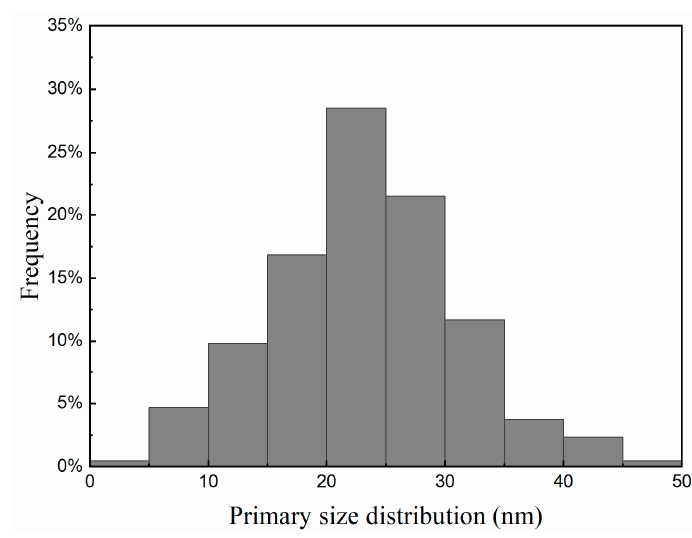
Figure 2. The primary size distribution of GDI PM. The accumulation of numerous primary particles created irregular structures known as particle agglomerates. An agglomerate’s fractal dimension ( Df ) represents the degree of compactness of the particles. The higher the fractal dimension, the more compact the structure of the agglomerate and the greater the overlap between its primary parti- cles [20,21]. ImageJ software measures the average diameter ( D P ) of easily identifiable primary particles to quantify these agglomerate morphologies. Equation (1) includes the fractal dimension ( Df ):